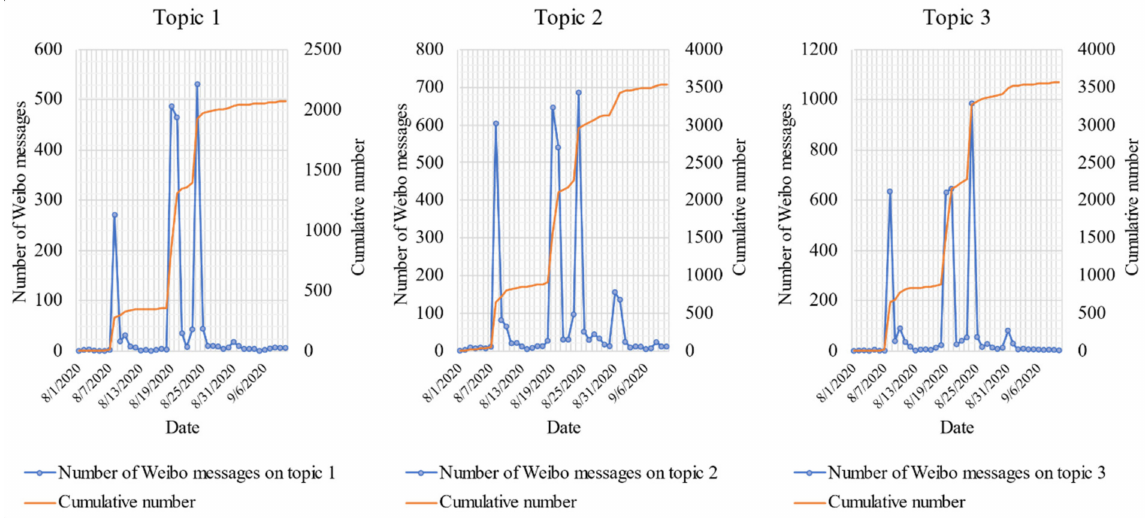
Figure 8. Time series data of public interest in the top three topic